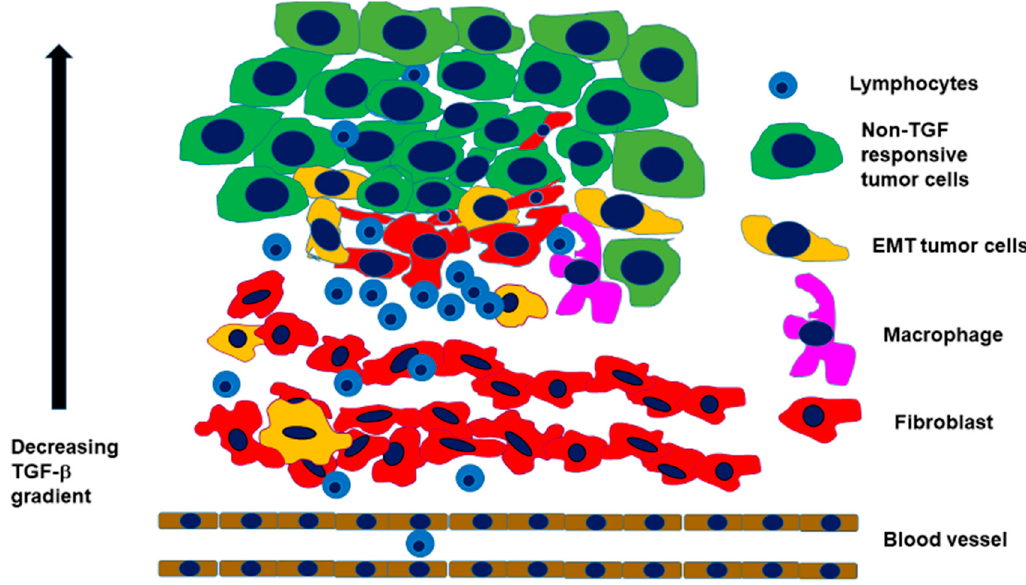
Figure 2. The TGF- β 1 gradient causes heterogeneity in the tumor cell nests. There are higher TGF- β 1 concentrations near the tumor vasculature, and the tumor cell nest has a decreasing gradient from its border towards the middle, which generates heterogeneity between the tumor–stroma interface and the tumor cell nest center [47]. The TGF- β 1 gradient contributes to the heterogenic architecture of the tumor cell nest, where the invasive front has a completely different functional and differentiation profile than the core of the tumor cell nest. Additionally, at the invasive front, tumor cells interact with fibroblasts, leukocytes, and other stromal cells. Some scattered tumor cells undergo EMT at the tumor cell nest–stroma interface and contain both epithelial and mesenchymal markers. The figure is based on a figure published by Mayorca-Giuliani and Erler [48], which has been updated by the published data of Nieto et al. [29].